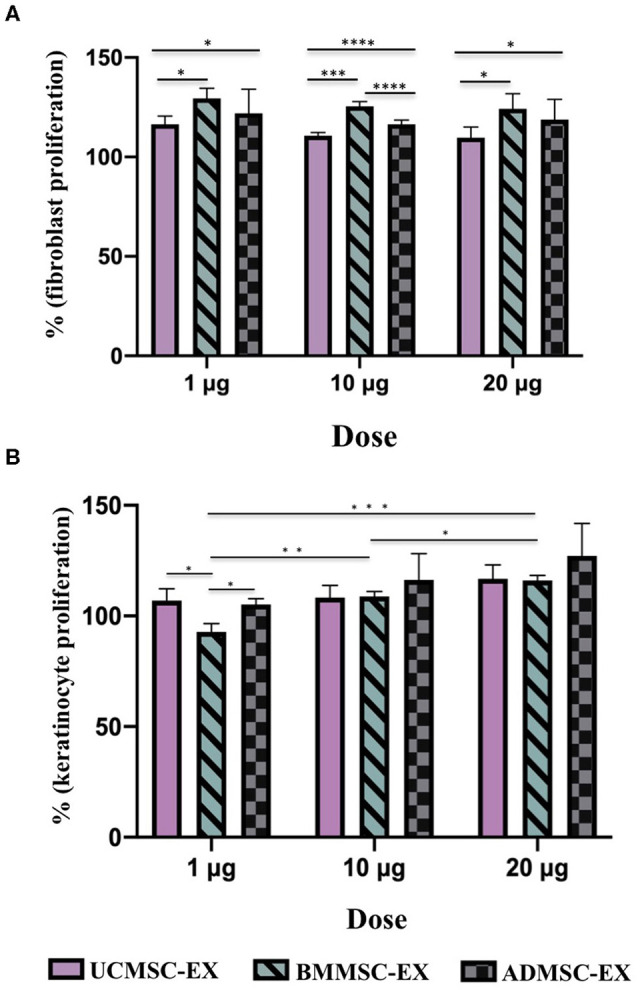
Capacity of primary dermal fibroblast and keratinocyte proliferation under stimulation of exosomes released by BMMSCs, ADMSCs, and UCMSCs cultured under serum- and xeno-free condition. Percentage of cell proliferation was normalized to the control (100%). (A) Fibroblast proliferation under exosome stimulation: There were differences between exosomes released from three sources of BMMSCs, ADMSCs, and UCMSCs within the same dose, in which BMMSC-derived exosomes have the greatest enhancement in the primary dermal fibroblasts. There was no difference in cell proliferation stimulation associated with doses, especially different doses of BMMSC-derived exosomes and ADMSC-derived exosomes, excepted for UCMSC-derived exosomes that dose of 20 μg expressed lower stimulation on cell proliferation compared to dose of 1 μg. (B) Keratinocyte proliferation under exosome stimulation: A stronger induction of keratinocyte proliferation was observed in the cell treated with the higher dose of exosomes, especially BMMSC-derived exosomes. With the dose of 1 μg exosomal protein, ADMSC- and UCMSC-derived exosomes exhibited a stronger capacity to enhance keratinocyte proliferation in comparison with UCMSC-derived exosomes which exhibited the lowest capacity to stimulate the proliferation. BMMSC-EX, BMMSC-derived exosomes; ADMSC-EX, ADMSC-derived exosomes; UCMSC-EX, UCMSC-derived exosomes. Statistical significance was determined by ANOVA and post-hoc Tukey HSD tests, and is indicated by: * where p < 0.05; ** where p < 0.01; *** where p < 0.001; **** where p < 0.0001.